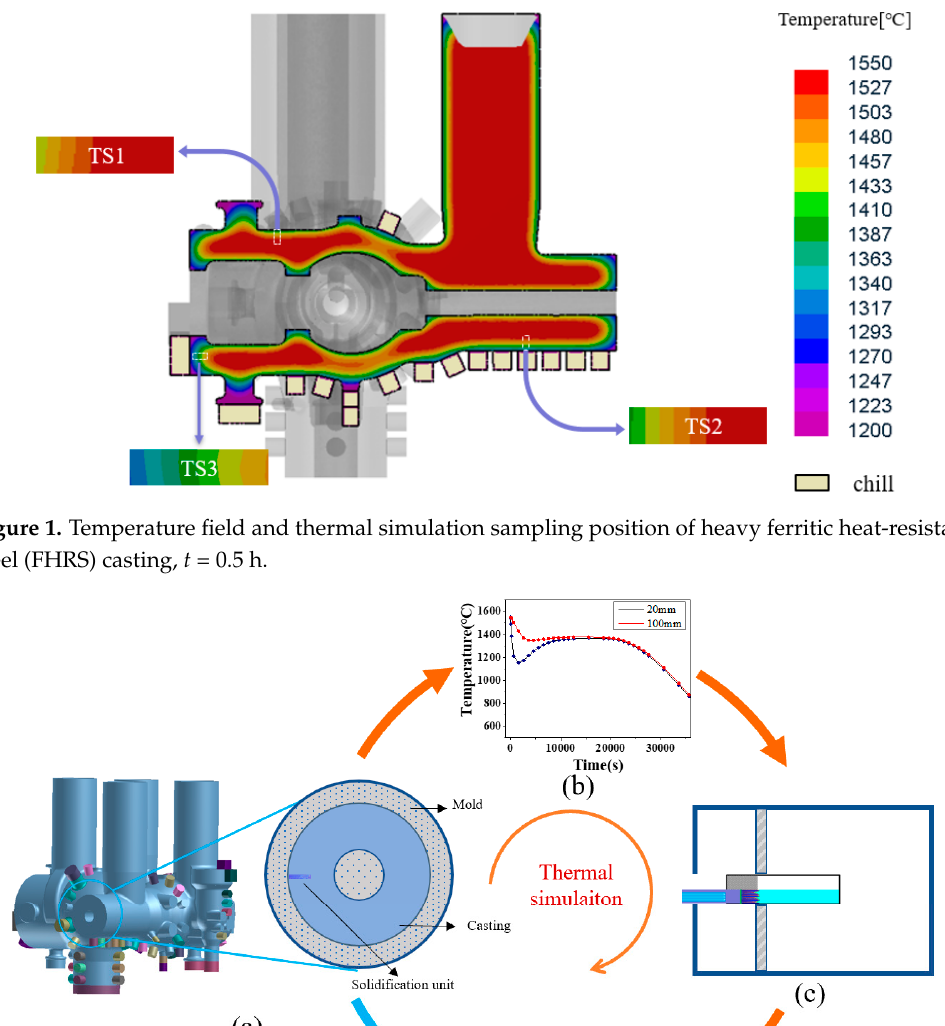
Figure 1. Temperature field and thermal simulation sampling position of heavy ferritic heat-resistant steel (FHRS) casting, t = 0.5 h.